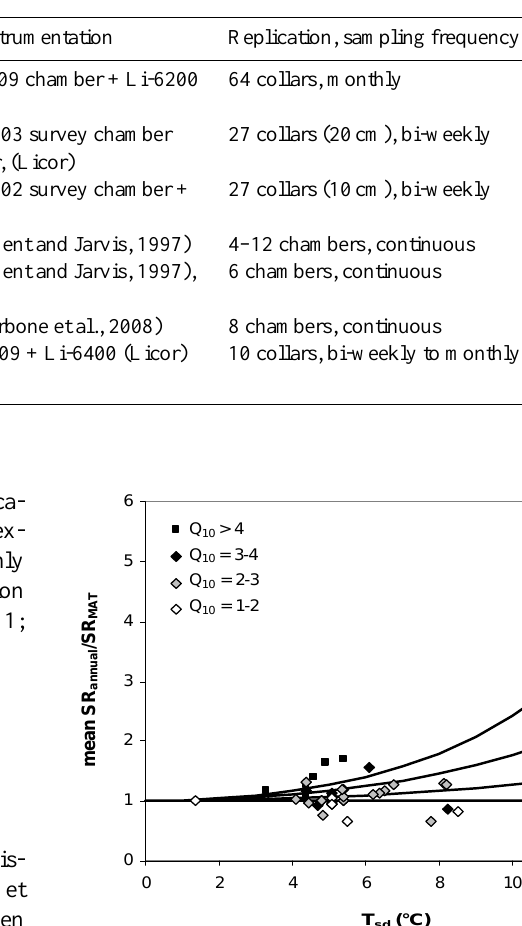
Table 2. Methods for measuring soil respiration for previously unpublished datasets. References as in Table 1. CDS and ODS refer to closed and open dynamic system, respectively.